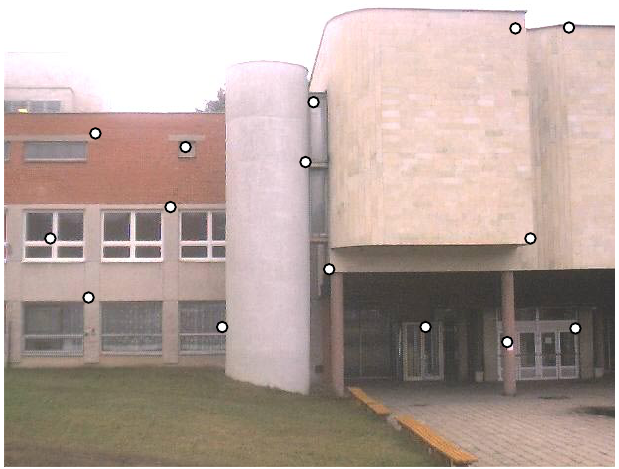
Fig 4. Outdoor test